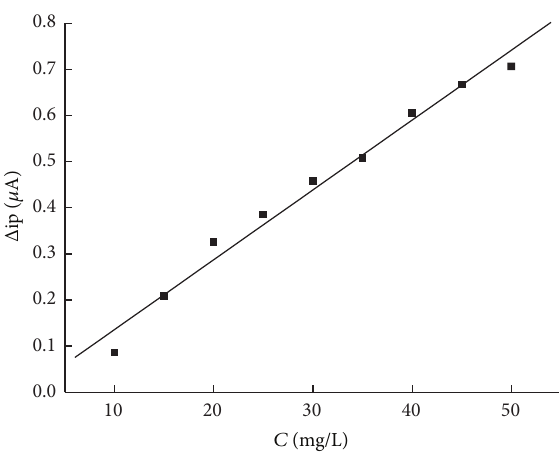
Figure 5: The working curve for the determination of